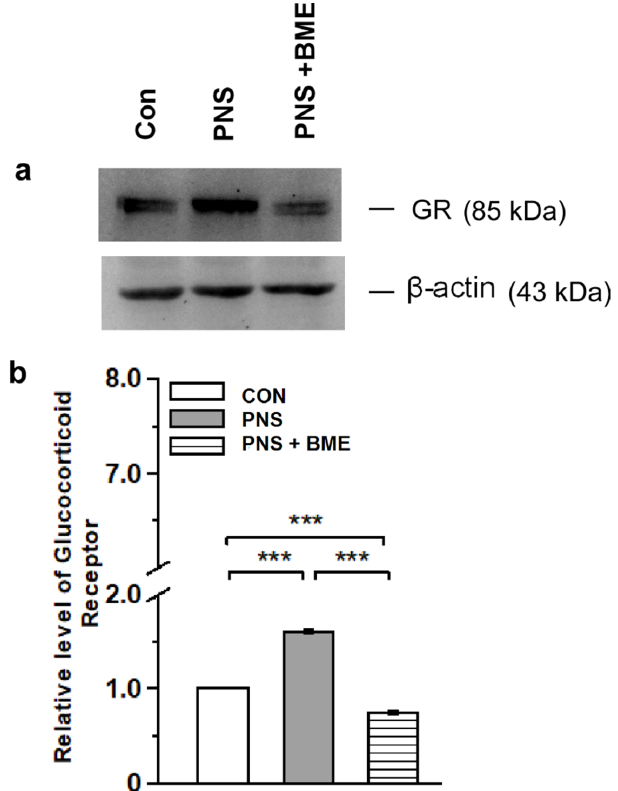
Figure 5. Effect of exposure to BME treatment on PNS-induced changes in offspring’s glucocorticoid receptor (GR) level in amygdale. ( a ) Representative Western blot showing that the level of GR varied across the experimental group; ( b ) Estimated level of GR suggests that exposure to BME treatment has a resilience effect on the PNS-induced changes. Data are expressed as mean ± SEM ( n = 6/each group). One-way ANOVA followed by Bonferroni post hoc test (for all pairwise multiple comparisons, statistical significance is indicated by *** p < 0.001).